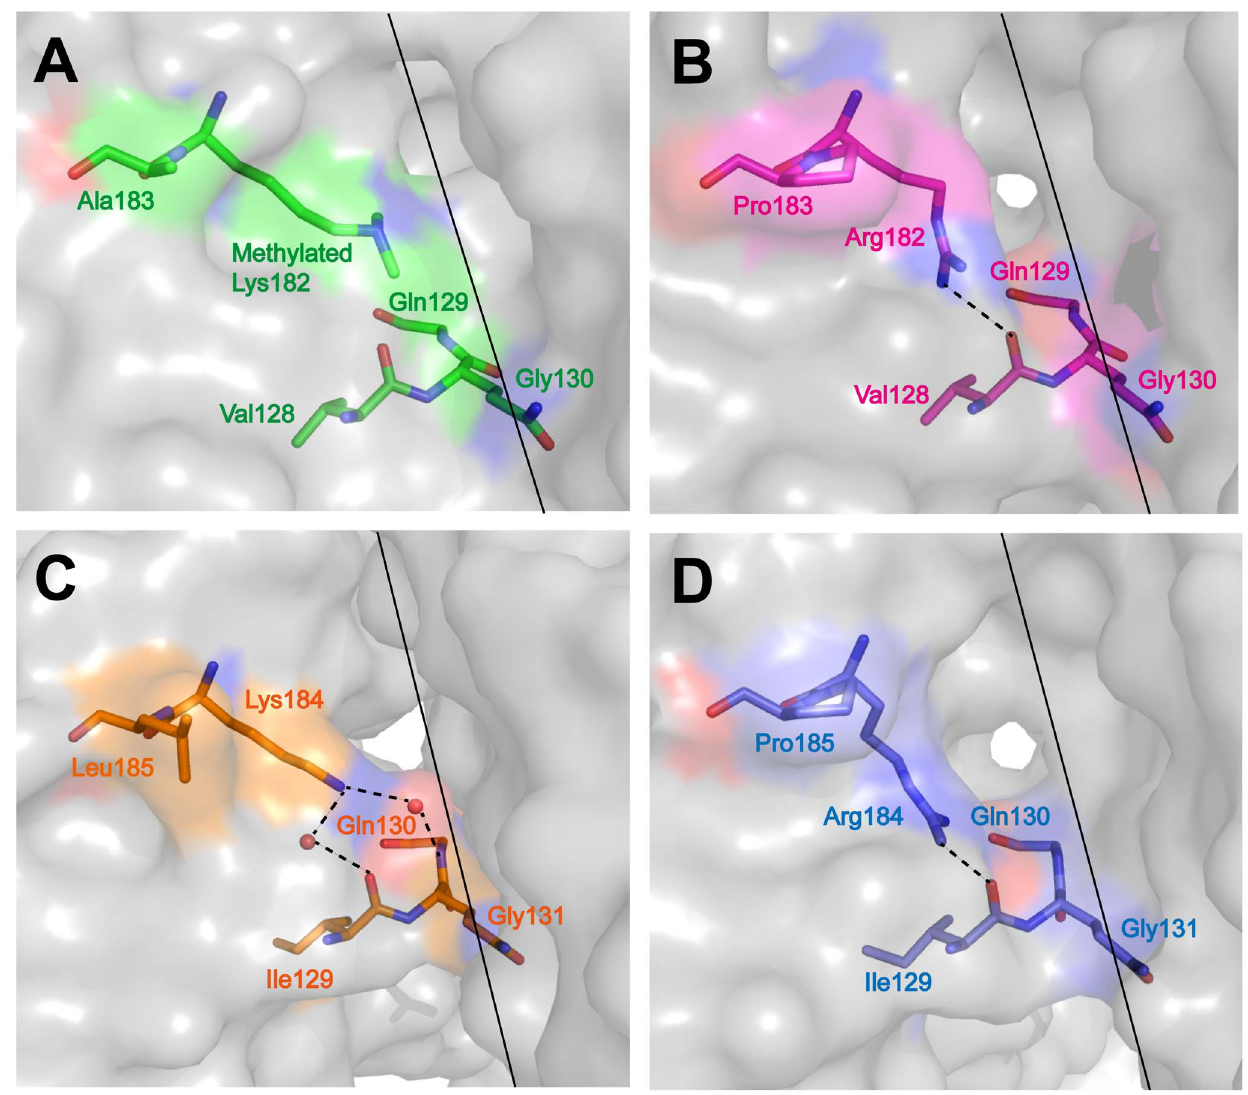
Figure 3. Comparison of the dimer interface surface structure of K182R, A183P Sc MnSOD and K184R, L185P Ca MnSODc to the WT proteins. The proteins are colored as: (A) WT Sc MnSOD, green; (B) K182R, A183P Sc MnSOD, red; (C) WT Ca MnSODc, orange; (D) K184R, L185P Ca MnSODc, blue. The dimer interfaces and hydrogen bonds are indicated as solid and dashed lines, respectively.